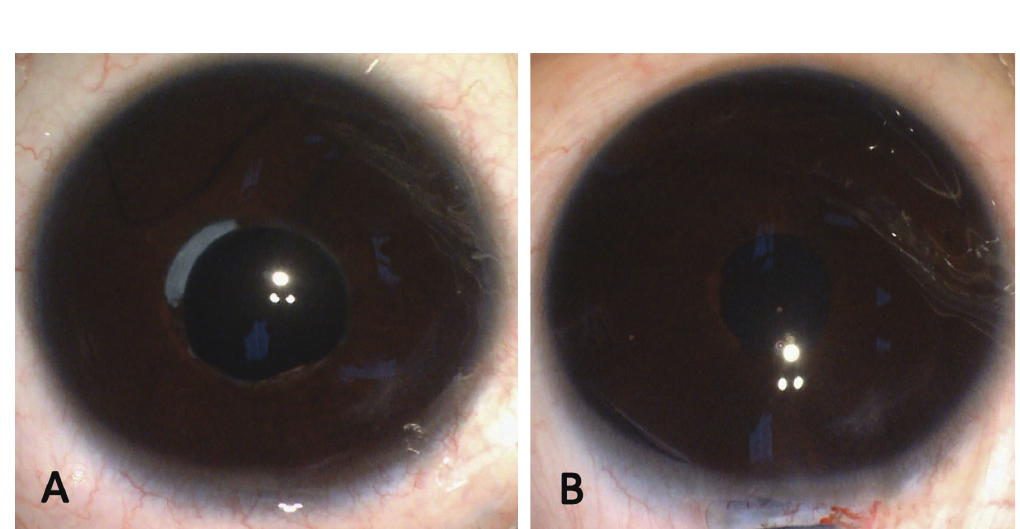
Figure 1: Representative anterior segment images before and after posterior synechiolysis. (a) Preoperative image of extensive and superior posterior synechia. Position, 6–3 o’clock. (b) Postoperative condition of (a), showing a round pupil, a centrally placed IOL, and a barely noticeable peripheral iridectomy.